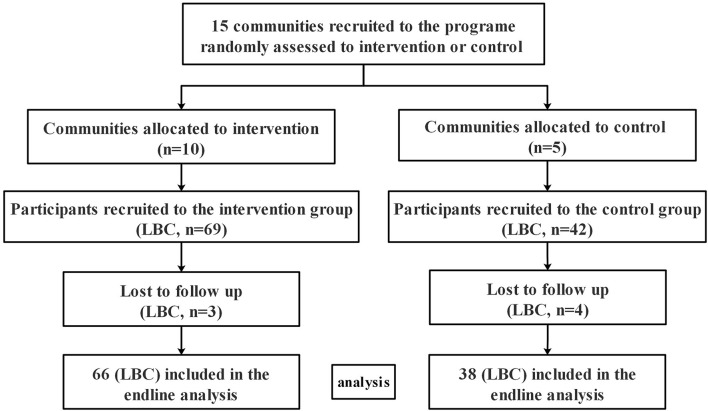
Participant flow.